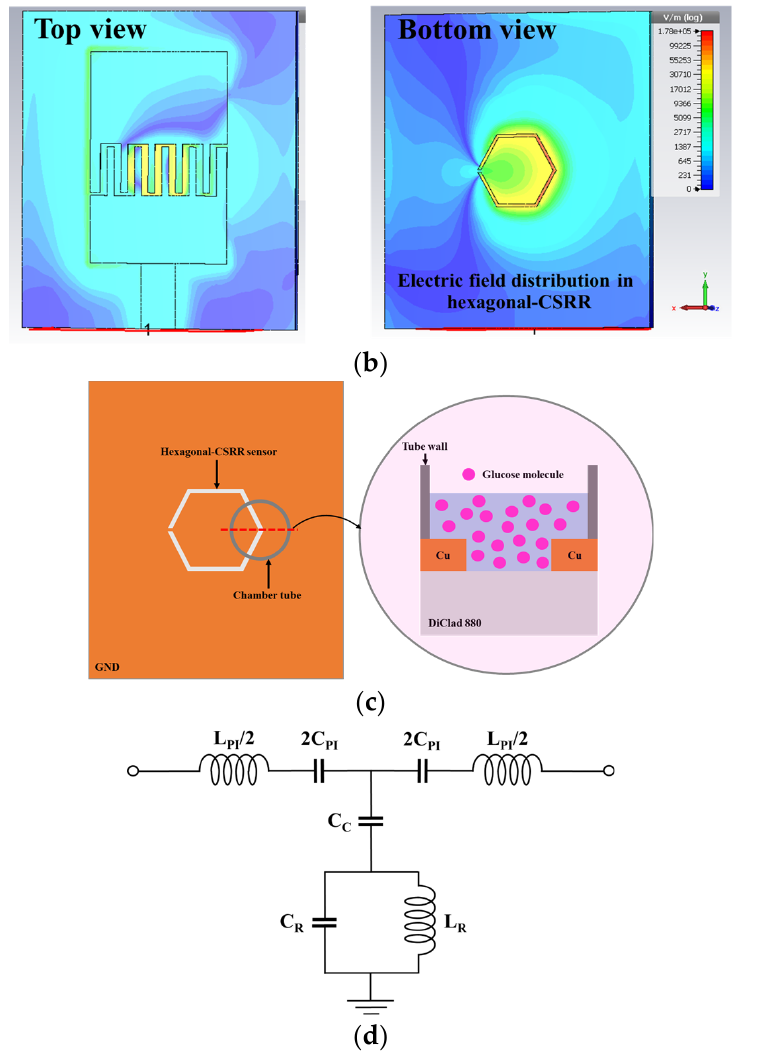
Figure 1. The proposed sensor: ( a ) geometry, ( b ) an electric field distribution, ( c ) a cross-sectional view at sensing area, and ( d ) an equivalent circuit model.